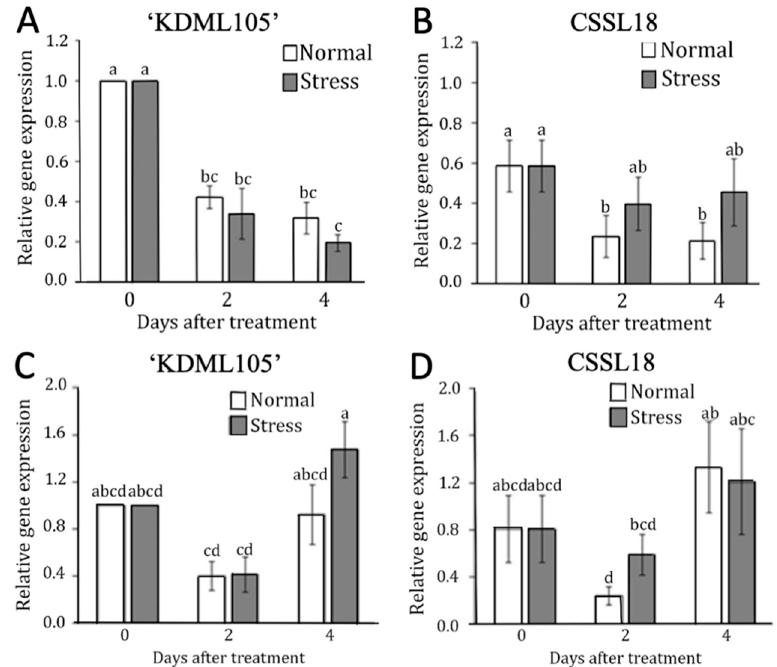
Figure 8. Relative expression of OsPHOT2 ( A , B ) and OsPDK ( C , D ) in ‘KDML105’ ( A , C ) and CSSL18 ( B , D ) in ‘KDML105’ ( A ) and CSSL18 ( B ) under normal and salt stress conditions for 0, 2, and 4 days. The different lower case letters show the significant difference of means, p < 0 . 05 .